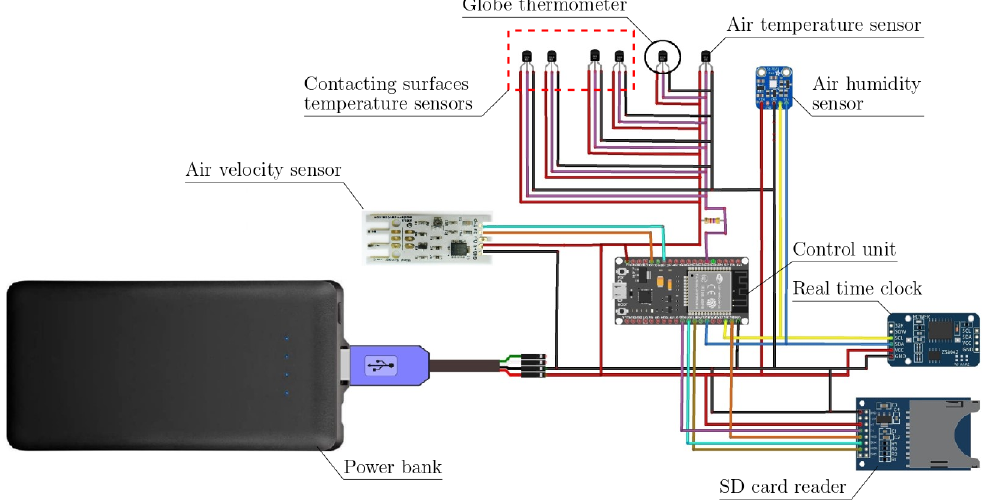
Figure 2. Schematic representation of the sensor station. Table 5. Technical properties of the employed